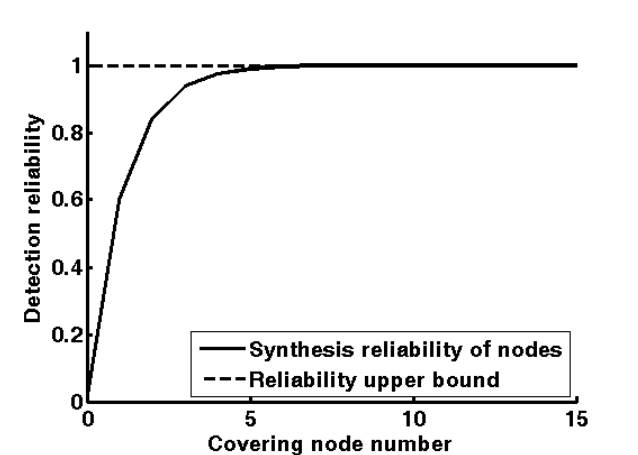
Figure 3. Detection reliability as a function of covering node